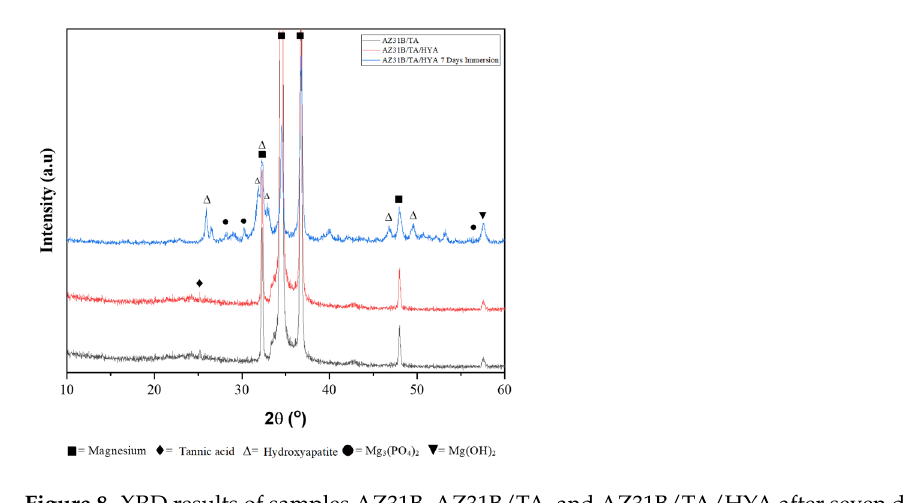
Figure 9. Changes in the pH of the solution in the immersion process of AZ31B, AZ31B/TA, and AZ31B/TA/HYA samples for seven days.